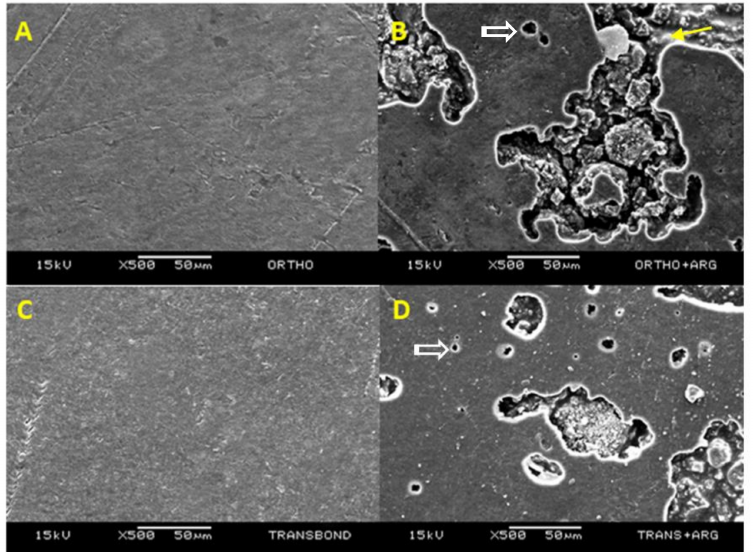
Figure 2. SEM images of the luting orthodontic resin cements tested. ( A ) Orthocem—The polished surface shows few discrepancies or porosities; ( B ) Orthocem + arginine —The polished surface depicts the presence of wide porosities ranging from 5 µ m to 100 µ m. Inside the porosity it is possible to see arginine particles covered with resin matrix (yellow arrow) as well as loose particles (white arrow); ( C ) Transbond XT—Polished surface showing minor irregularities; ( D ) Transbond XT + arginine—Polished surface showing increased number of small porosities ranging from 5 µ m to 30 µ m (open arrow) and fewer wider porosities. Loose arginine particles are visible (white